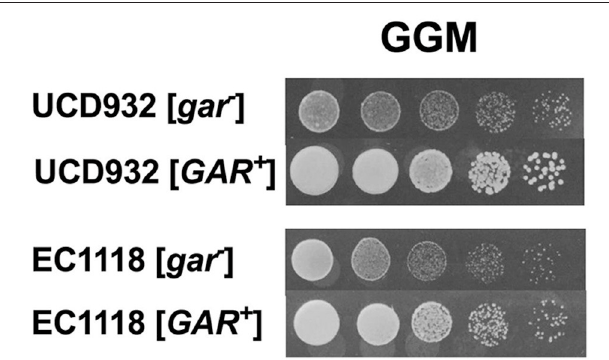
FIGURE 2 | The [ GAR + ] phenotype displays heritability. Growth of [ GAR + ] yeast isolates from the selective (GGM) on GGM medium following passage on permissive YPD medium as compared to the respective parent [ gar − ] strain previously maintained only on YPD. Spot assays represent five-fold serial